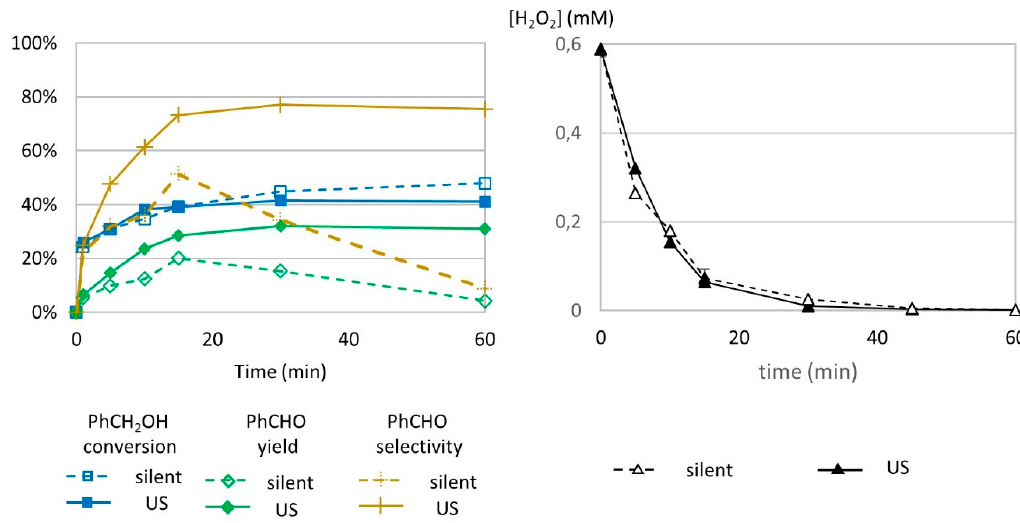
Figure 6. Oxidation of PhCH 2 OH as a function of time in silent condition and under US irradiation (20 kHz). Reaction conditions: 571 mM PhCH 2 OH, 1 molar eq. H 2 O 2 , 1% molar eq. FeSO 4 , 5.61 mL H 2 O, 70 °C (left) and monitoring of H 2 O 2 over time. Reaction conditions: 584 mM H 2 O 2 ; 5.5 mM FeSO 4 ; 5.988 mL water (right). Silent conditions: Argon bubbling; US conditions: 547 kHz, P acous = 55.5 W L − 1 h − 1.